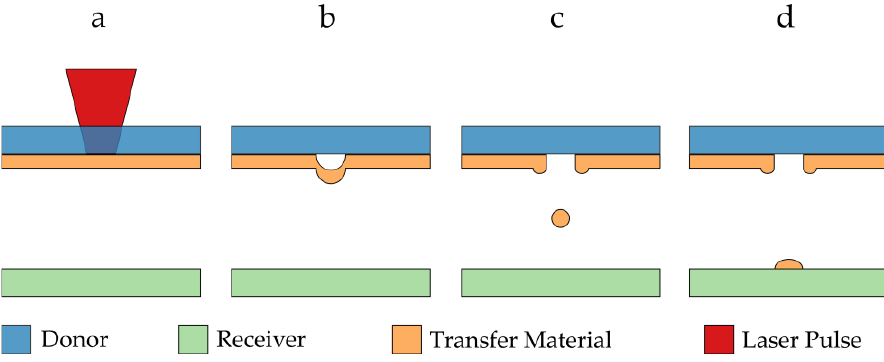
Figure 1. Schematic illustration of the basic principle of the LIFT process: ( a ) a laser pulse is focused on the interface between a transparent donor substrate and transfer material; ( b ) a gas pocket develops, expands and accelerates the transfer material away from the donor substrate; ( c ) a certain volume of material is ejected from the donor; ( d ) the material deposits on the receiver substrate to form a voxel at a predefined position.